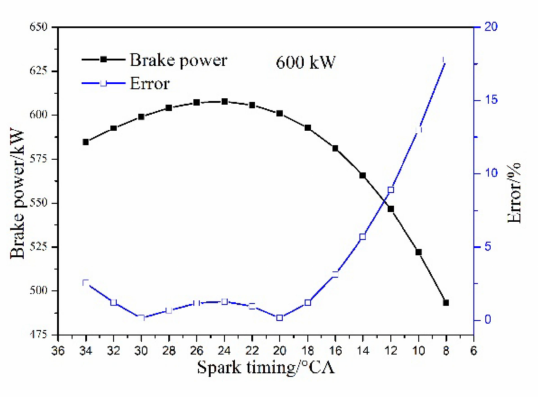
Figure 7. Engine power at different ignition times.